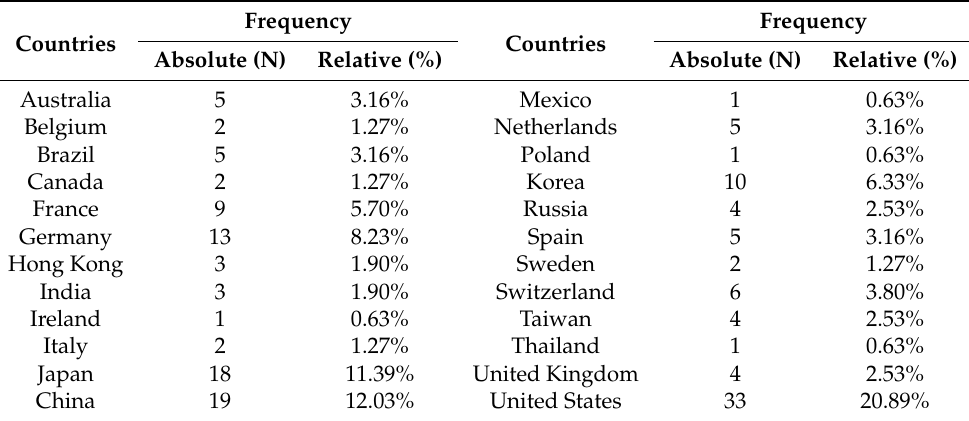
Table 1. Distribution of the samples by